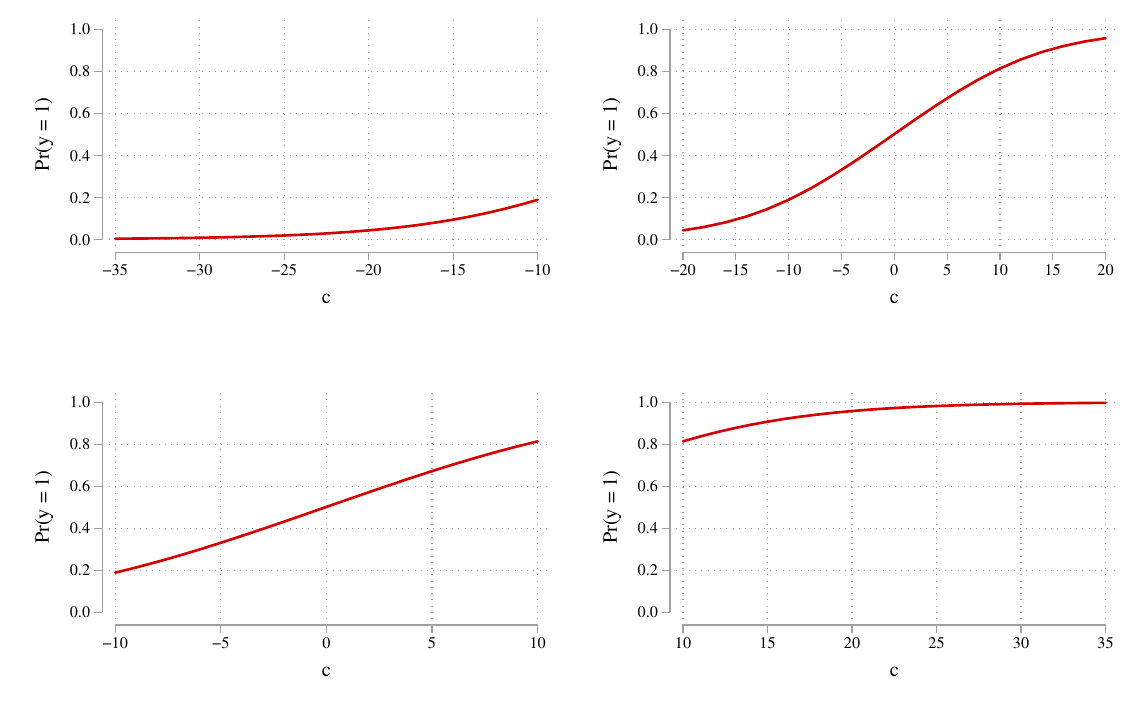
Figure 4: Simulated data: different effects on the predicted probability of y = 1 despite the same coefficient estimate of β =